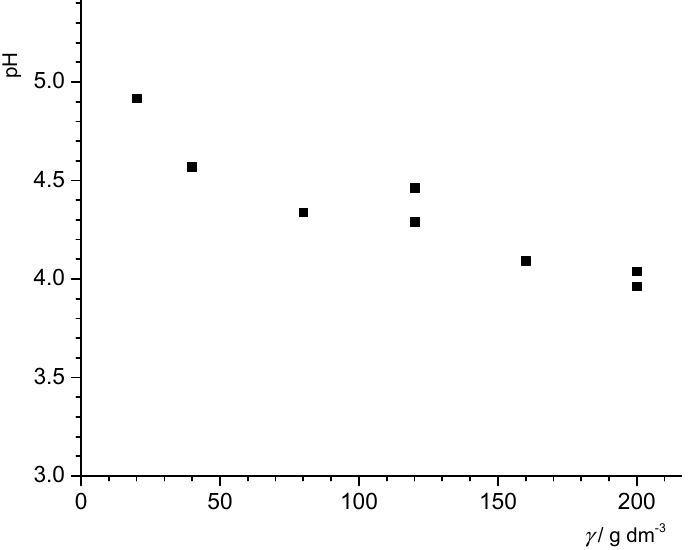
Figure 10. Results from mass titrations of PTFE-B-200 powder in MilliQ water, θ = 25 °C.